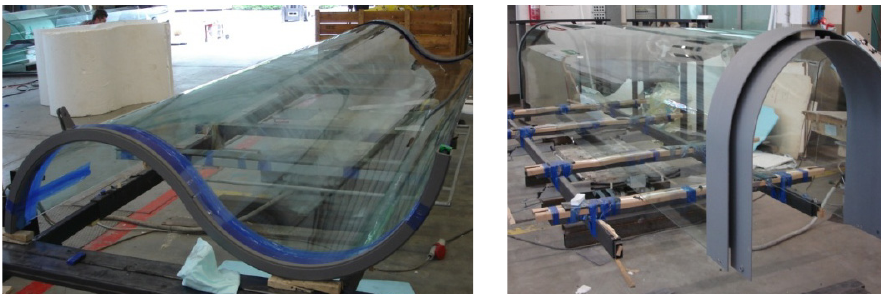
Figure 1a and b: possible shapes of hot bent